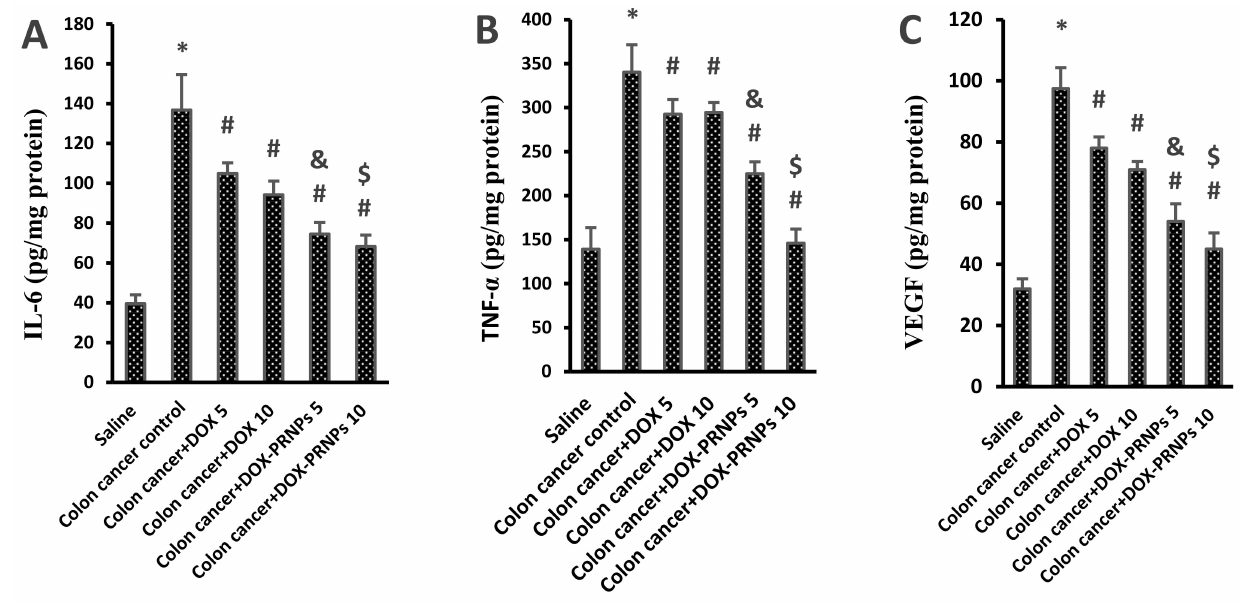
Figure 11. Level of the proangiogenic factors in the colon homogenates of the experimental groups. ( A ) IL-6, ( B ) TNF- α and ( C ) VEGF. *: versus saline group, #: versus colon cancer control group, &: versus colon cancer + DOX 5 mg/kg and $: versus colon cancer + DOX 10 mg/kg, p < 0.05. PRNPs: